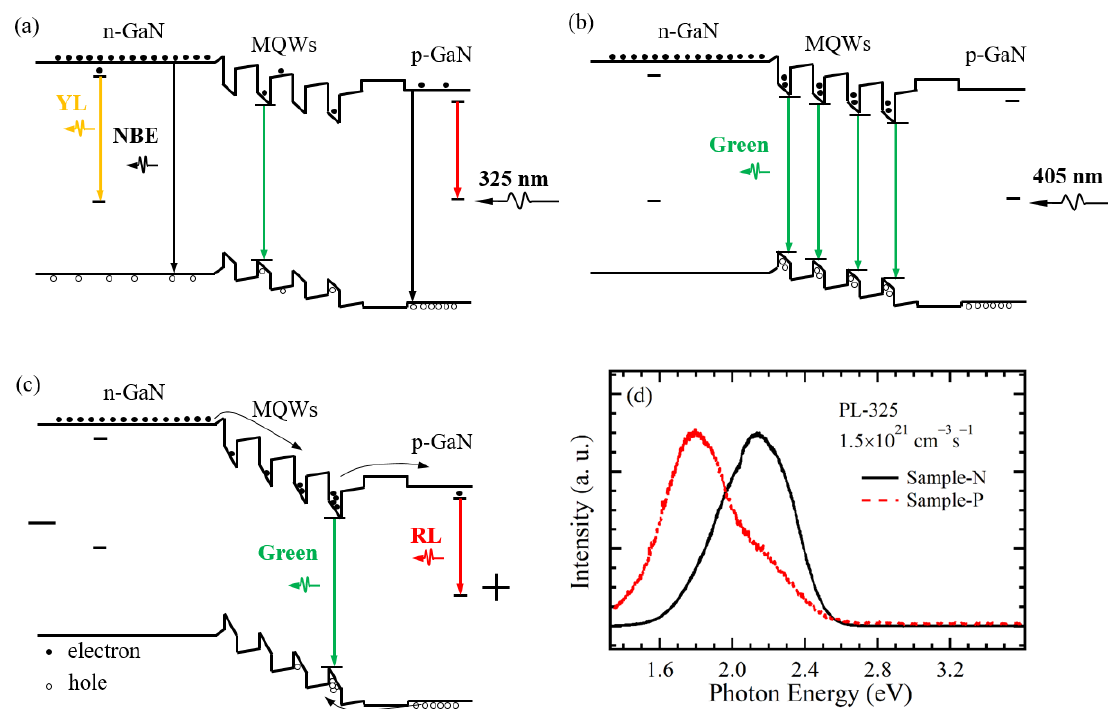
Figure 3. Energy band diagrams from the undoped GaN buffer layer to the p-GaN layer under excitation by 325-laser ( a ), 405-laser ( b ), and current ( c ). ( d ) Normalized spectra of the Sample-N and Sample-P measured under 325-laser.